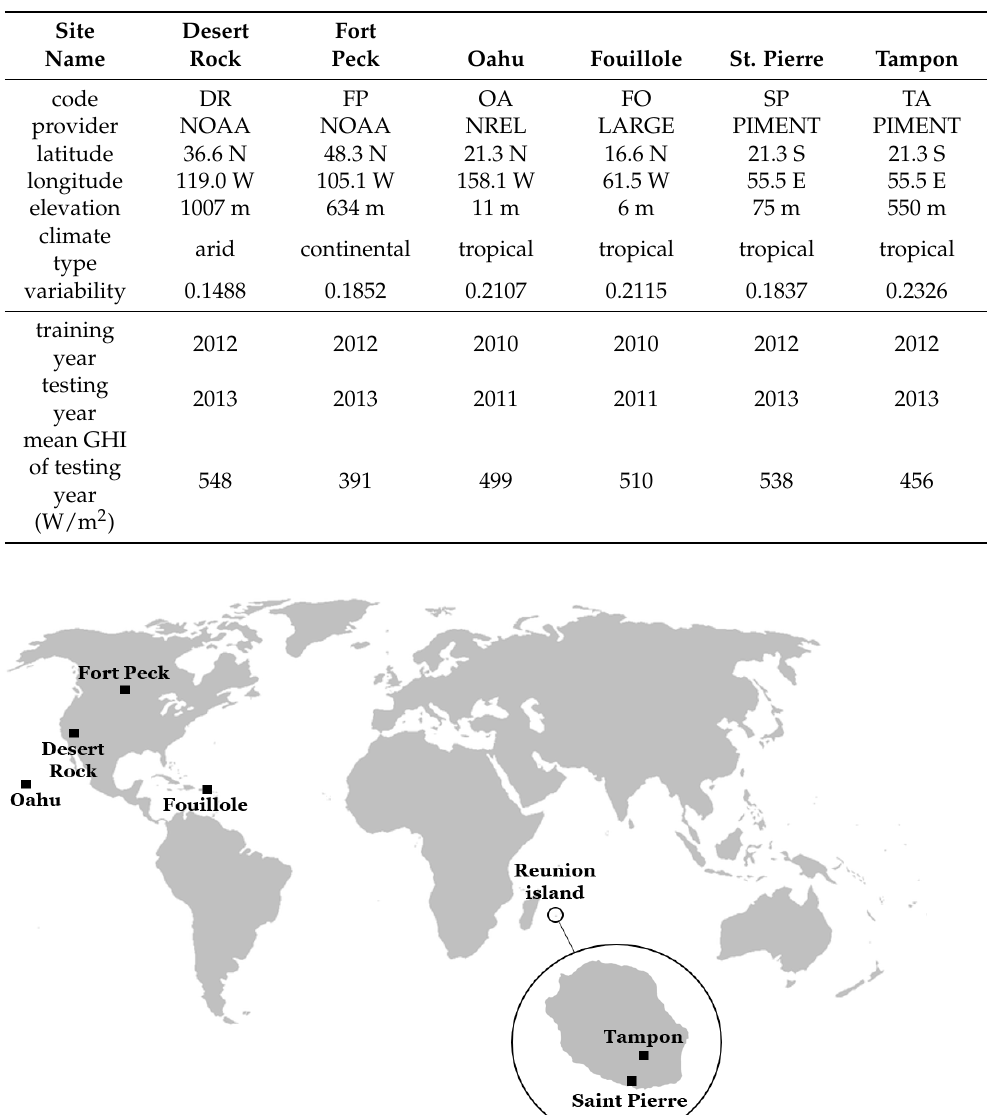
Table 1. Site characteristics.